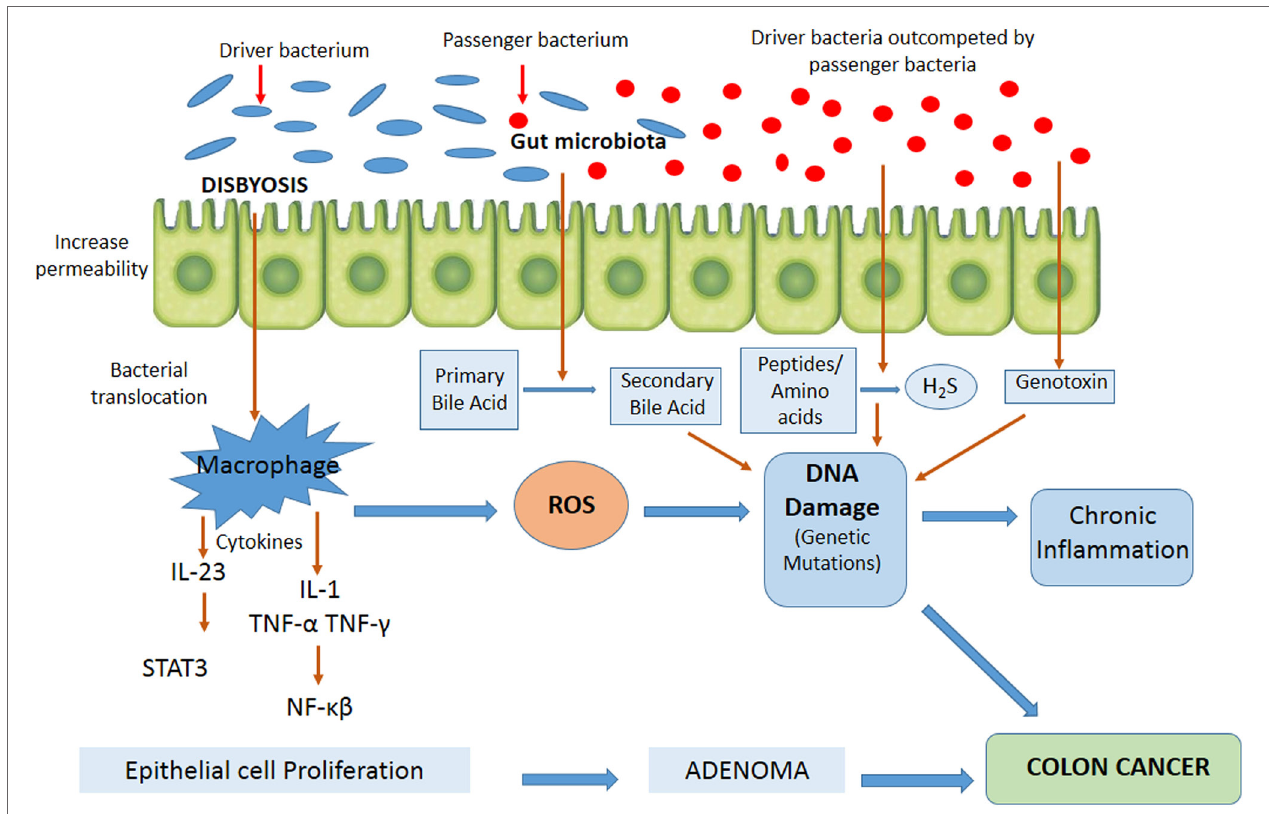
FiGURe 2 | Mechanisms possibly involved in microbial colorectal cancer promotion and the dynamic model “bacterial driver-passenger.” Gut microorganisms may promote colorectal cancer onset and progression by different processes, such as the induction of a chronic inflammatory state, the biosynthesis of genotoxins interfering with the cell cycle regulation or directly damaging DNA, or the production of toxic metabolites. According to the model, “bacterial driver-passenger” occurs a change in the composition of the gut microbiota. At the beginning of colorectal cancer progression, driver bacteria are able to initiate the development of the disease. Following tumorigenesis initiation, an alteration of the environment occurs, resulting in the overgrowth of passenger bacteria. ROS, reactive oxygen species; STAT3, signal transducer and activator of transcription 3; H 2 S, hydrogen